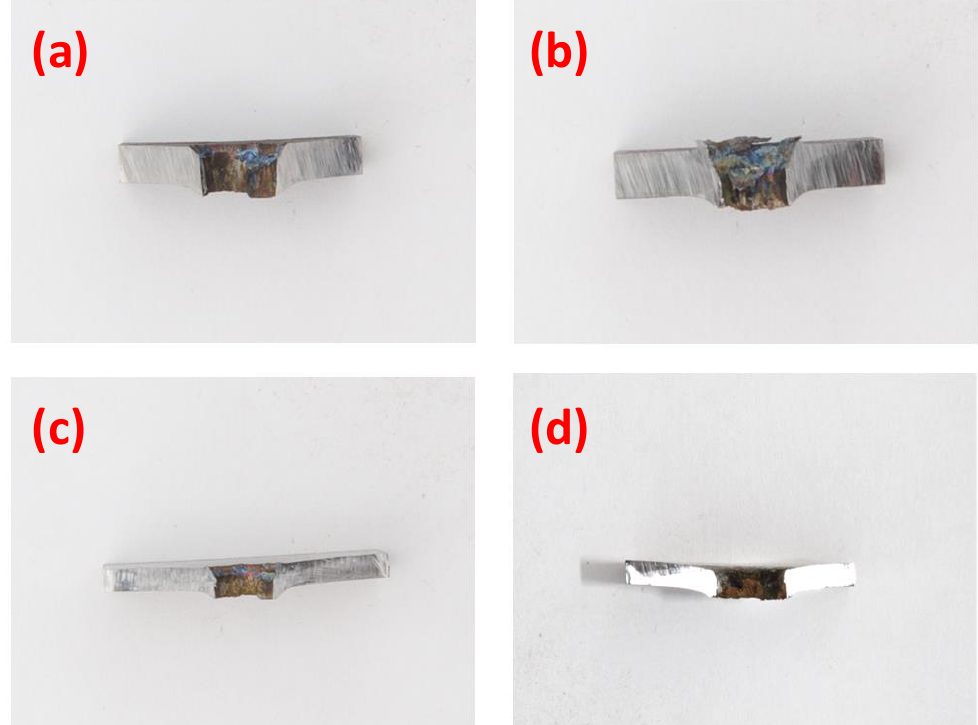
Figure 10. Cross sections of perforated plates. In detail: ( a ) 3 mm plate impacted by 5 mm fragment at 1075 m/s; ( b ) 3 mm plate impacted by 3.5 mm fragment at 1549 m/s; ( c ) 2 mm plate impacted by 5 mm fragment at 861 m/s; ( d ) 2 mm plate impacted by 3.5 mm fragment at 1023 m/s.